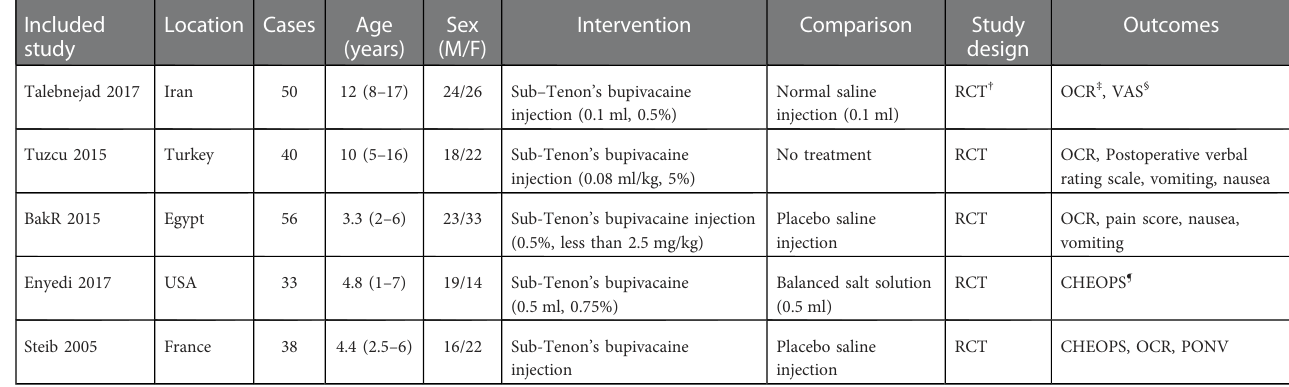
TABLE 1 General characteristics of included studies. Included